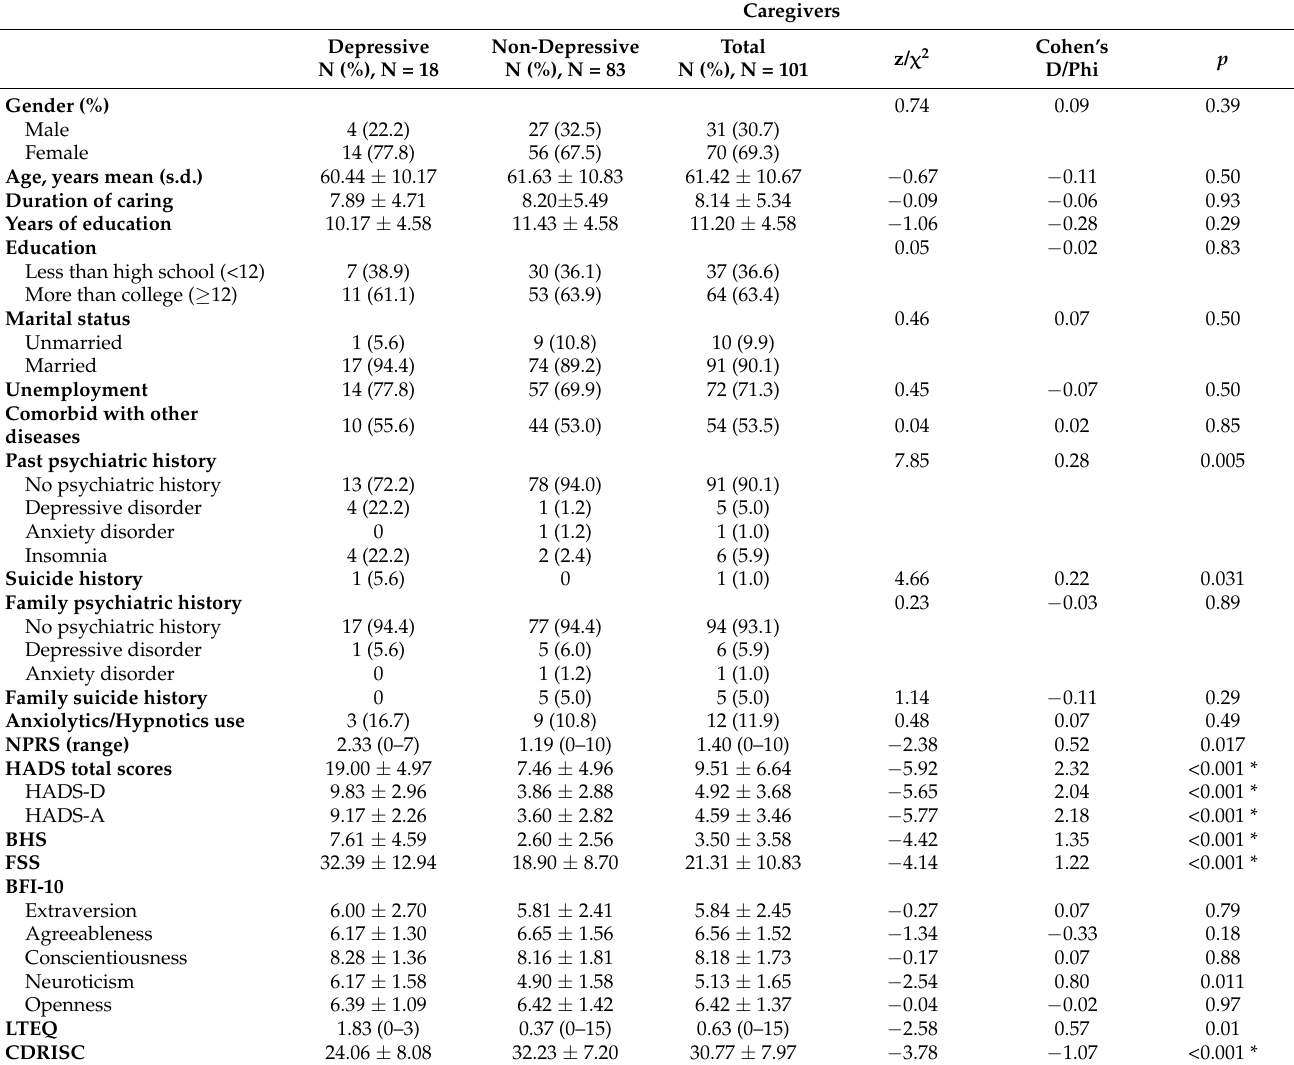
Table 2. Demographic and clinical characteristics of the caregivers at 12-month follow-up (N = 101). Caregivers